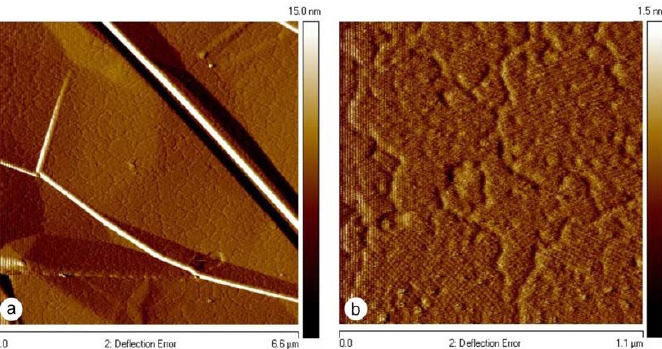
Figure 4. AFM images of a mosaic of crystalline SbpA S-layer domains on graphene. ( a ) An overview, ( b ) a zoomed view.